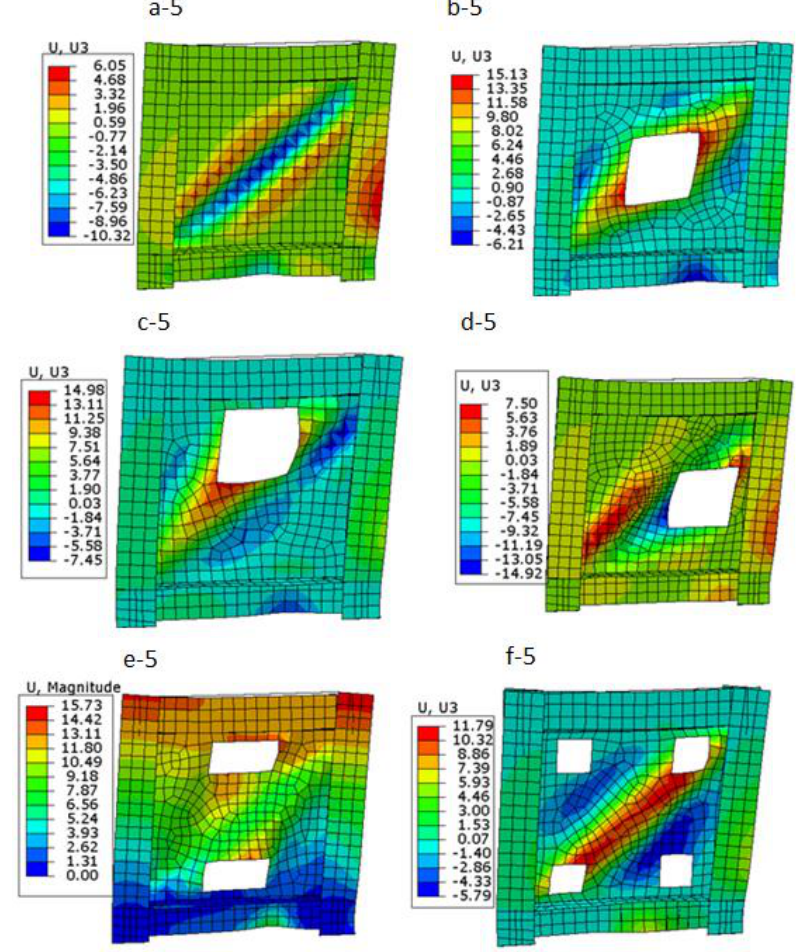
Figure 20. Out of plane displacement of shell parts model (a–f) .